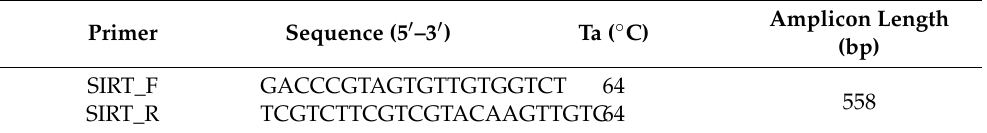
Table 2. Primers: sequences and